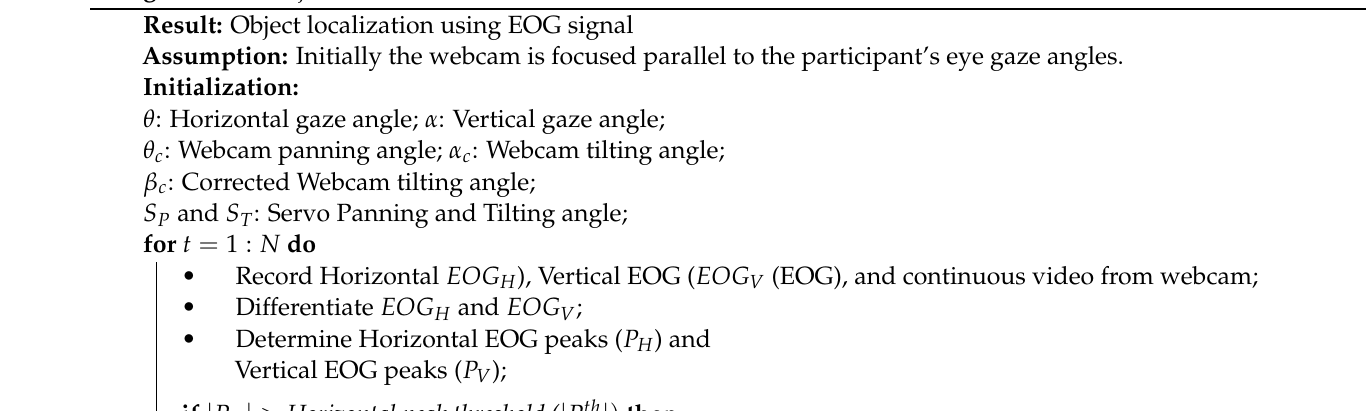
Algorithm 1: Object